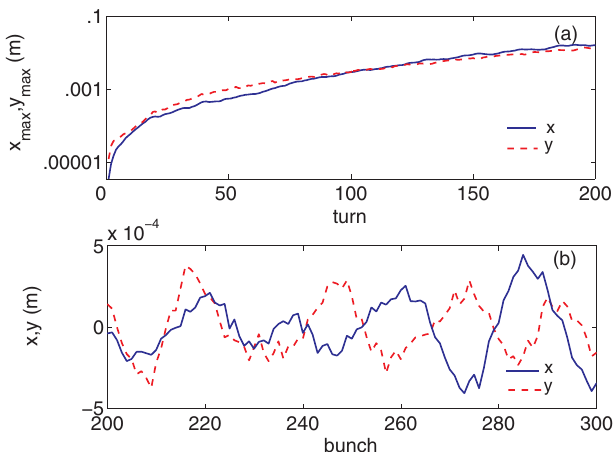
FIG. 18. (Color) Growth of the amplitude (a) and bunch oscil- (cid:1) 10 G . Primary electrons are produced lation pattern (b) for B z uniformly and secondary ones are produced with (cid:3) (cid:1) 0 : 5 and a reflection of (cid:3) 0